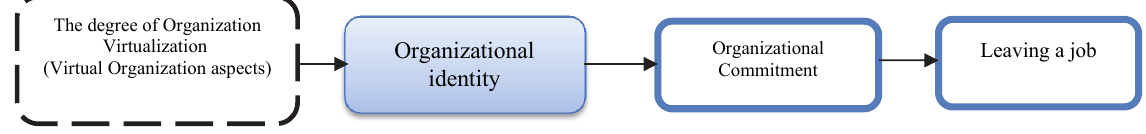
Fig. 2. Relationship between the degree of virtualization of the organization and the organizational